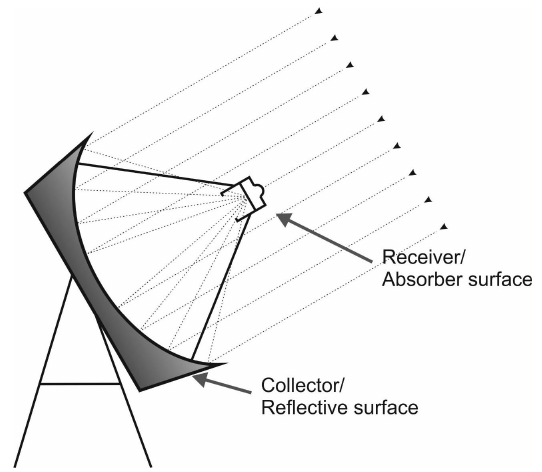
Figure 1. Solar dish collector representation.